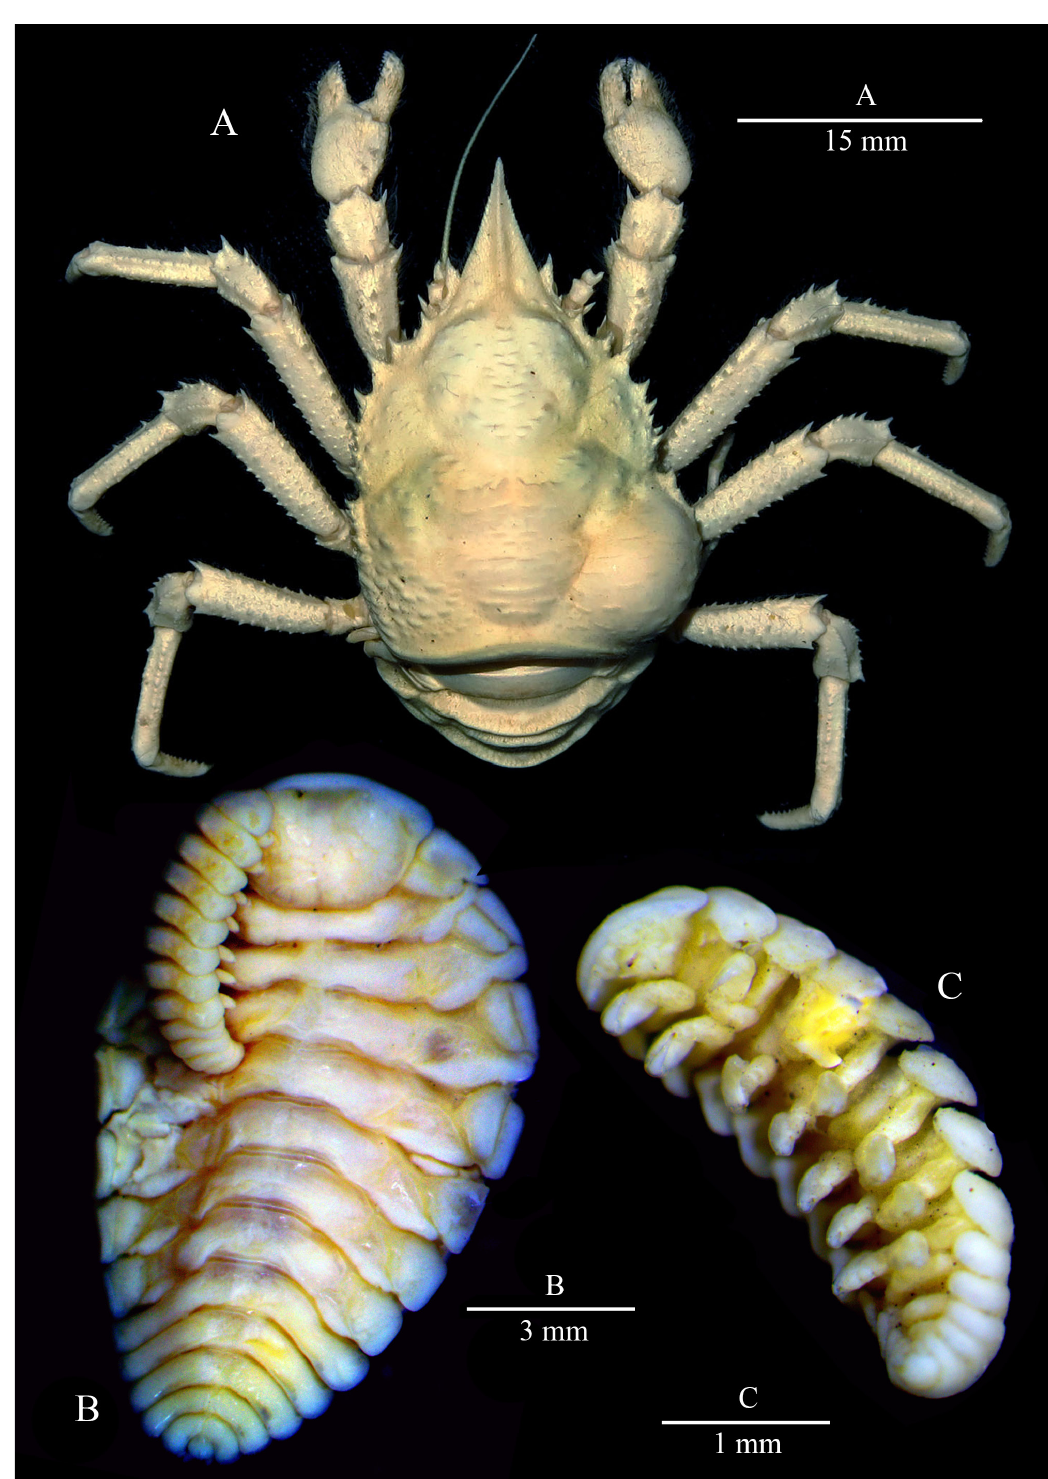
Fig. 1. Micrographs of Pleurocryptella altalis sp. nov. and host Munidopsis petalorhyncha Baba, 2005 (ZMMU Ma 3504). A . Munidopsis petalorhyncha , ♂, with swelled right branchial chamber from Pleurocryptella altalis sp. nov. B . Pleurocryptella altalis sp. nov., holotype, ♀, dorsal view (ZMMU Mc 1420) with attached allotype, ♂ (ZMMU Mc 1421). C . Pleurocryptella altalis sp. nov., allotype, ♂, oblique ventral view (ZMMU Mc